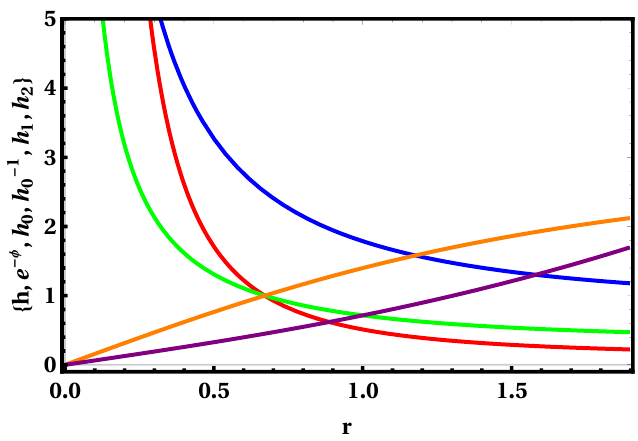
Figure 2 . The function, h , which is the red line and the various warp factors of the metric eq. (4.1) in type IIB theory that realizes small N = (4 , 0) superconformal symmetry. The dilaton, e − φ is the blue line, the warping factors h is the purple and finally the 1 /h L = 1 , c 1 = 2 and c 2 = 5